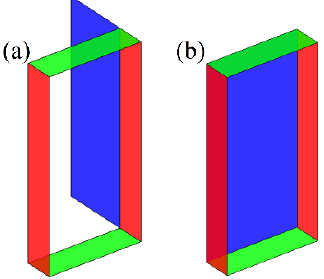
Figure 5. Door frames' planes. (a) . Opened (b) . Closed As mentioned before, the point cloud is transformed into a coordinate system described at the beginning of section